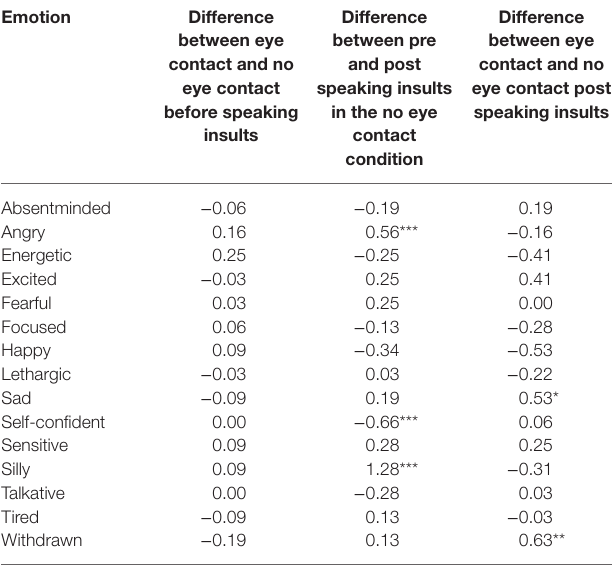
TABLE 2 | Self-reported emotions: Differences between conditions and over time.